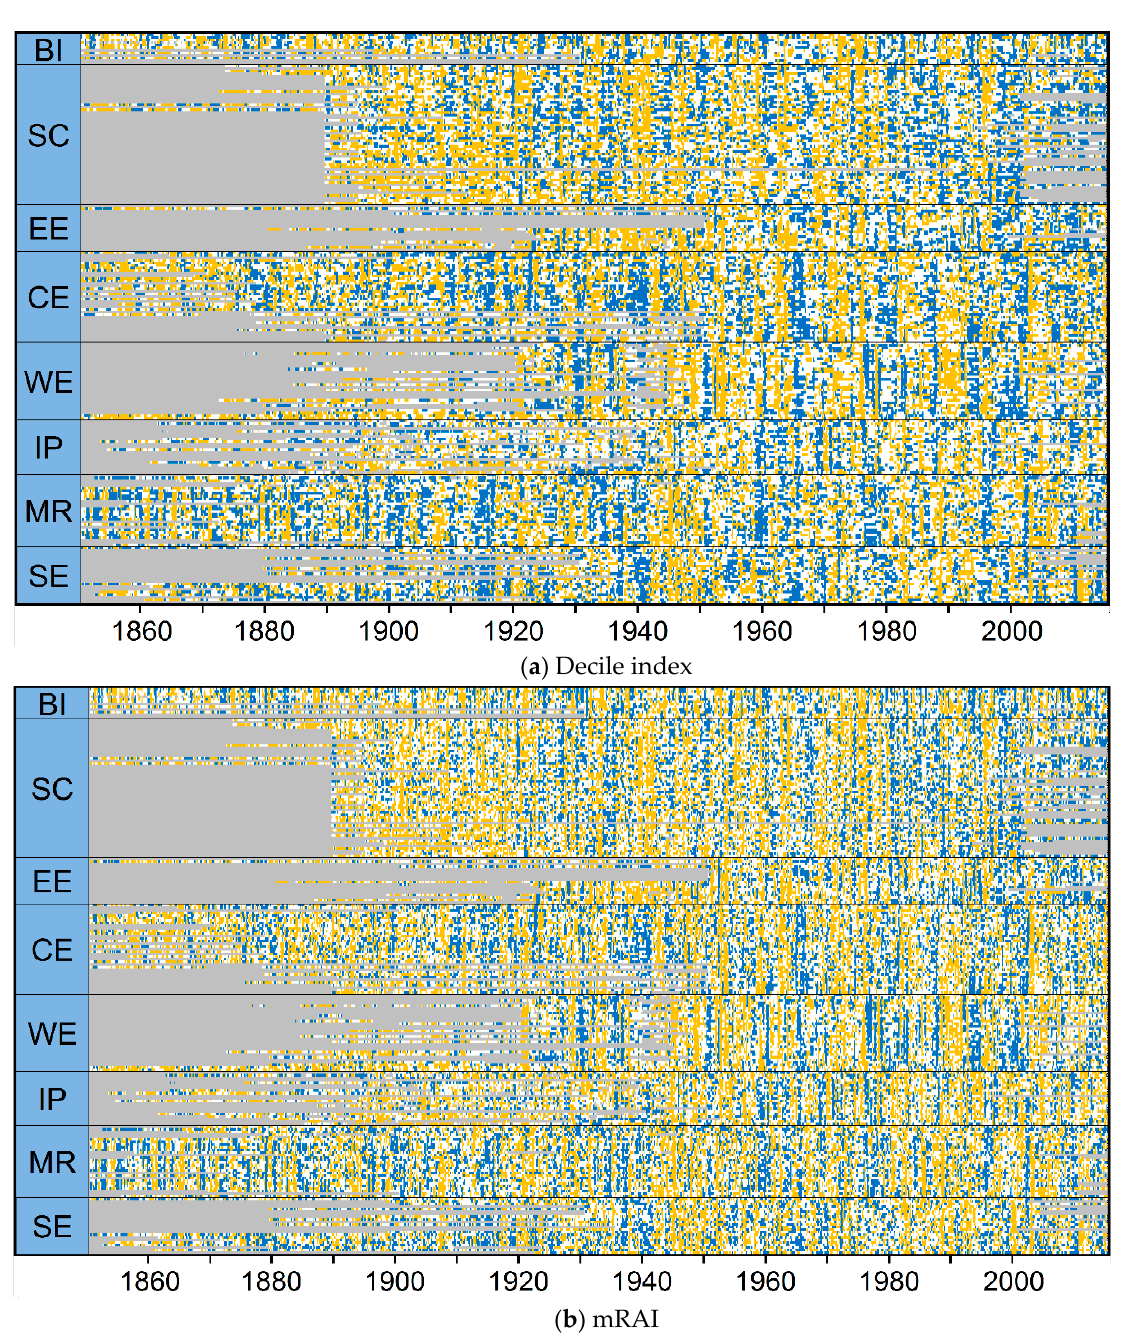
Figure 2. Occurrence of dry (orange bars) and wet periods (blue bars) at 220 stations within the eight sub-regions (for region abbreviations please refer to Figure 1) in Europe from 1851 to 2015 (light grey: missing data; white: no event). Part ( a ) shows the results for the decile index and ( b ) those for the mRAI.